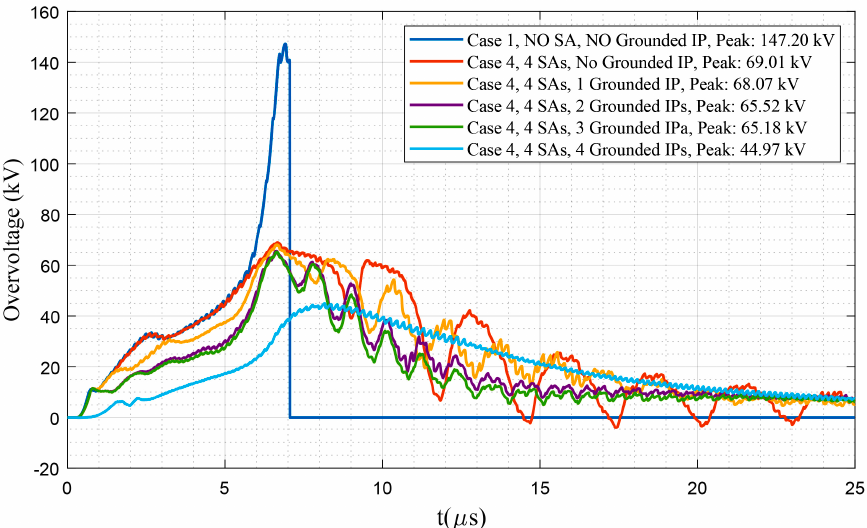
Figure 32. Comparison among the overvoltage stress at terminal c of the transformer mounted at pole #36 under di ff erent combinations of grounding and guy wire (GW) configurations of intermediate poles (IP); Network with dry poles considering four surge-arrester-protected transformers under a lightning strike on pole #35.